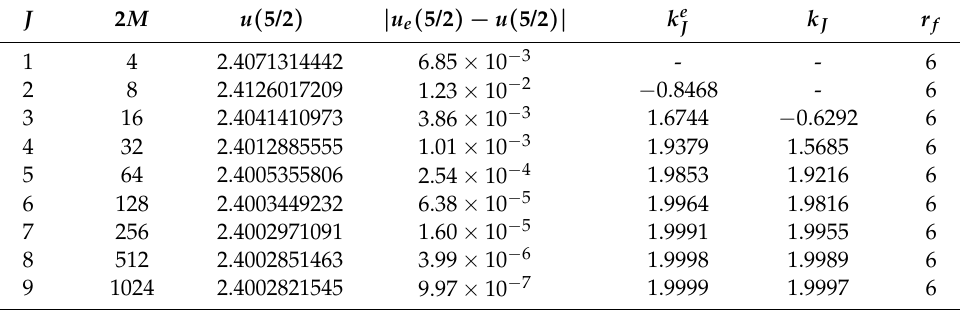
Table 3. Solutions to (18) where u e ( 5/2 ) = 2.400281157801 using